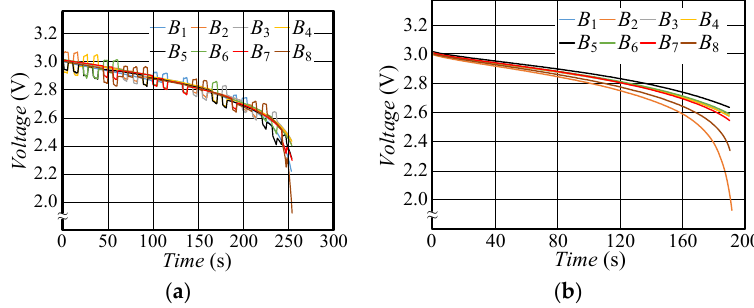
Figure 11. Variation in voltage when discharging: ( a ) with balancing; ( b ) without balancing. Table 3. Battery voltage during discharging with and without the balance operation.